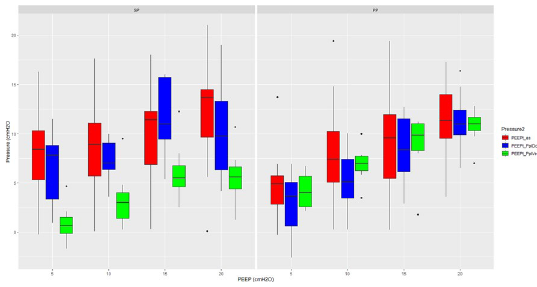
Fig. 1 Box‑and‑whisker plots of esophageal pressure and pleural pres‑ sure in supine position and in prone